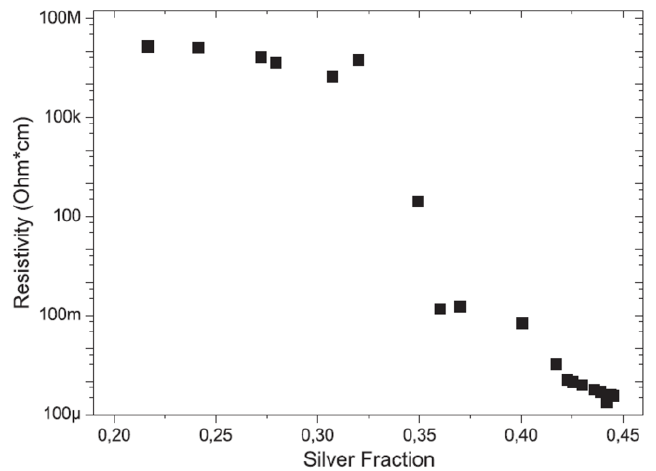
Figure 22. Change of the electrical resistivity of thin PTFE films with embedded Ag NPs with increasing filling factor. (Reproduced with permission from [47], Copyright IOP Publishing